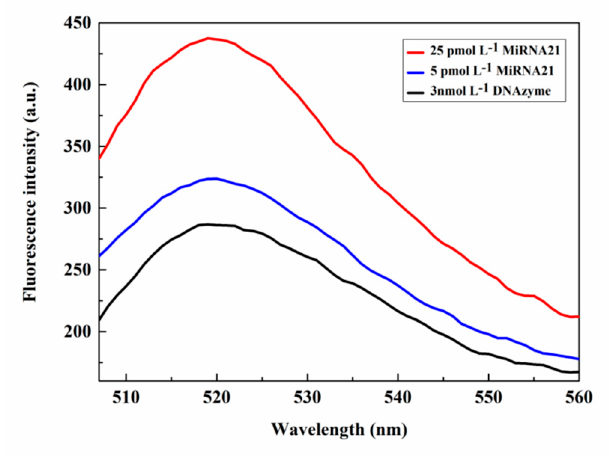
Figure 2. Fluorescence spectra for various concentrations of miR-21.